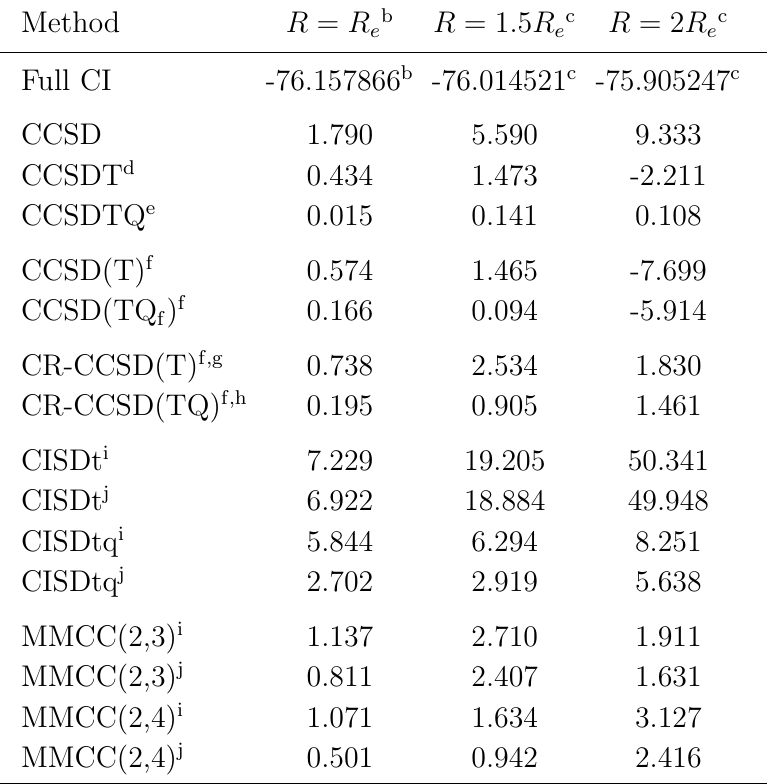
Table 2. A comparison of various CC and CI-based MMCC ground-state energies with the cor- responding full CI and CISDt and CISDtq results obtained for the equilibrium and two displaced O molecule with a DZ basis set. geometries of the H 2